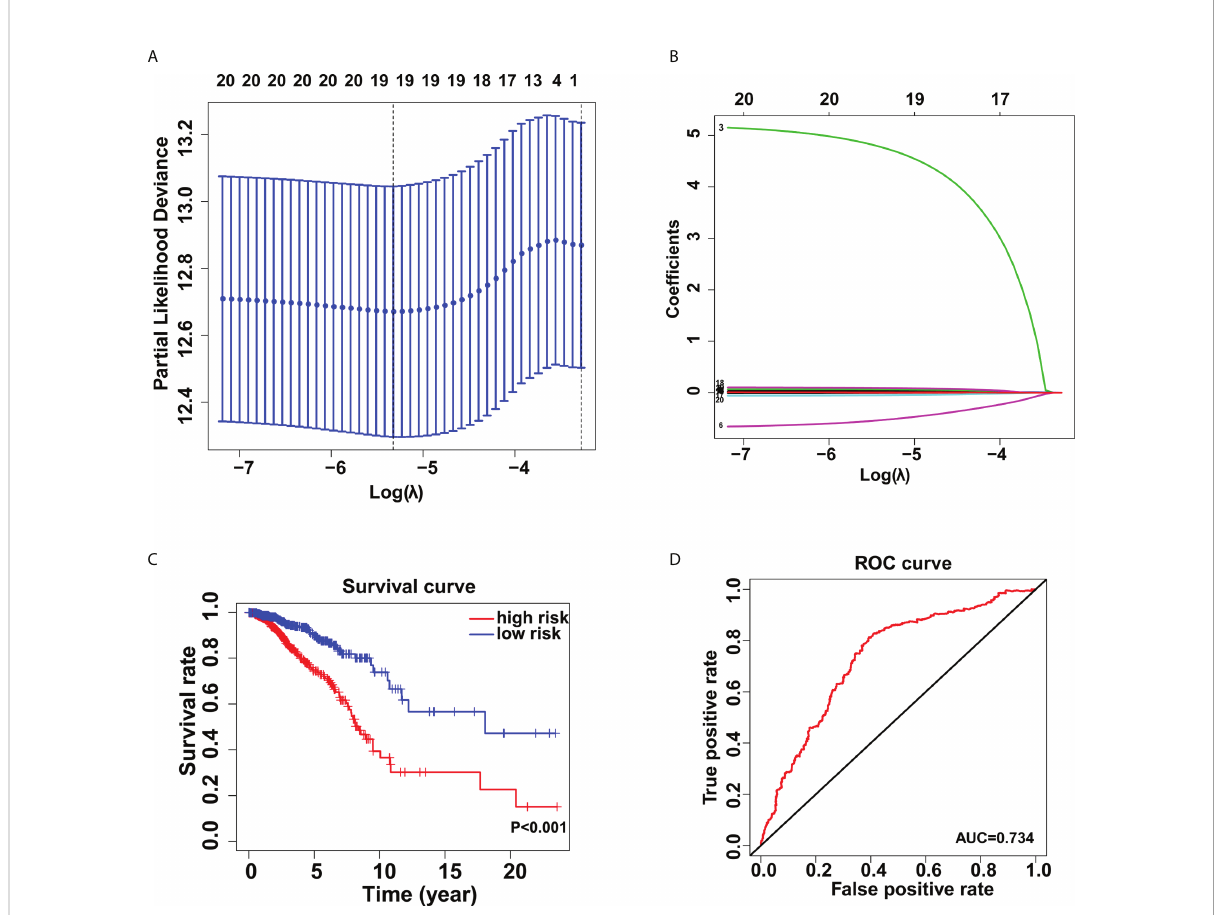
FIGURE 2 Establishment of the glycogene signature in breast cancer. Lasso regression analysis (A, B) for identi fi cation of the glycogene signature. (C) Kaplan-Meier analysis of overall survival rates in low- and high-risk groups. (D) Validation of the glycogene signature ’ s predictive performance by the receiver operating characteristic (ROC)